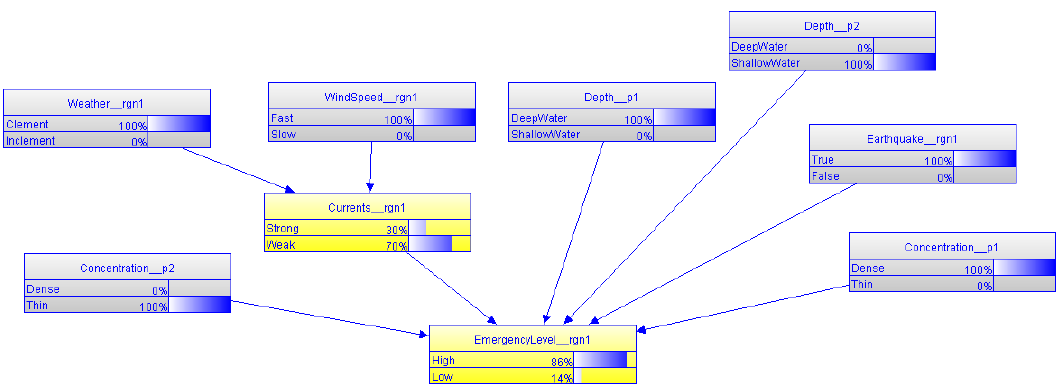
Figure 13. The MEBN reasoning for the emergency level.